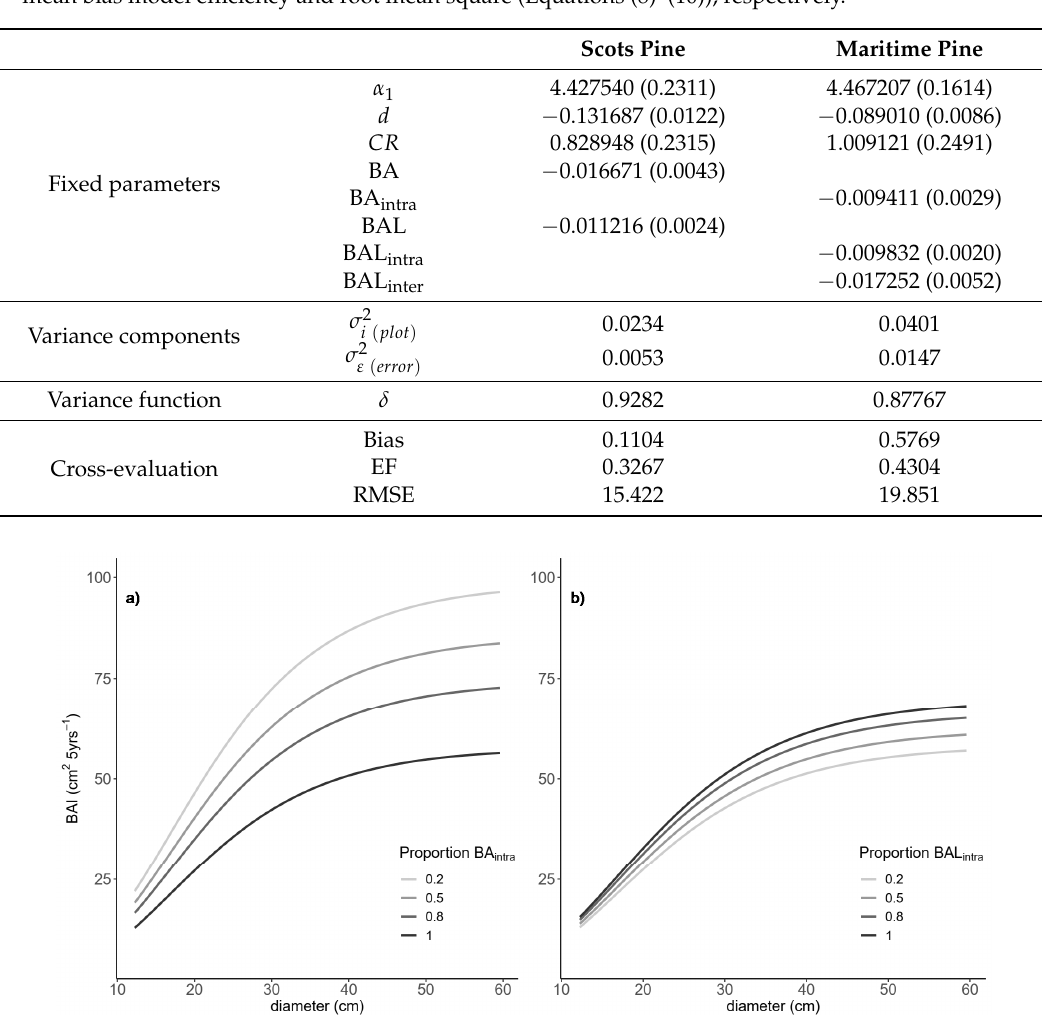
Figure 4. Variation of individual-tree basal area increment (cm 2 5 years − 1 ) across the range in initial diameter for Maritime pine with: ( a ) increasing proportion of intraspecific size-symmetric competition (Proportion BA intra = BA intra /BA, = 0.2, 0.5, 0.8, or 1.0) for a stand with BA = 50 m 2 ha − 1 , BAL intra = 10 m 2 ha − 1 , and BAL inter = 0; and ( b ) increasing proportion of intraspecific size-asymmetric competition (Proportion BAL intra = BAL intra /BAL, = 0.2, 0.5, 0.8, or 1.0) for a stand with BA intra = 30 m 2 ha − 1 and BAL = 30 m 2 ha − 1 , and CR fixed at its mean value (CR = 0.35).